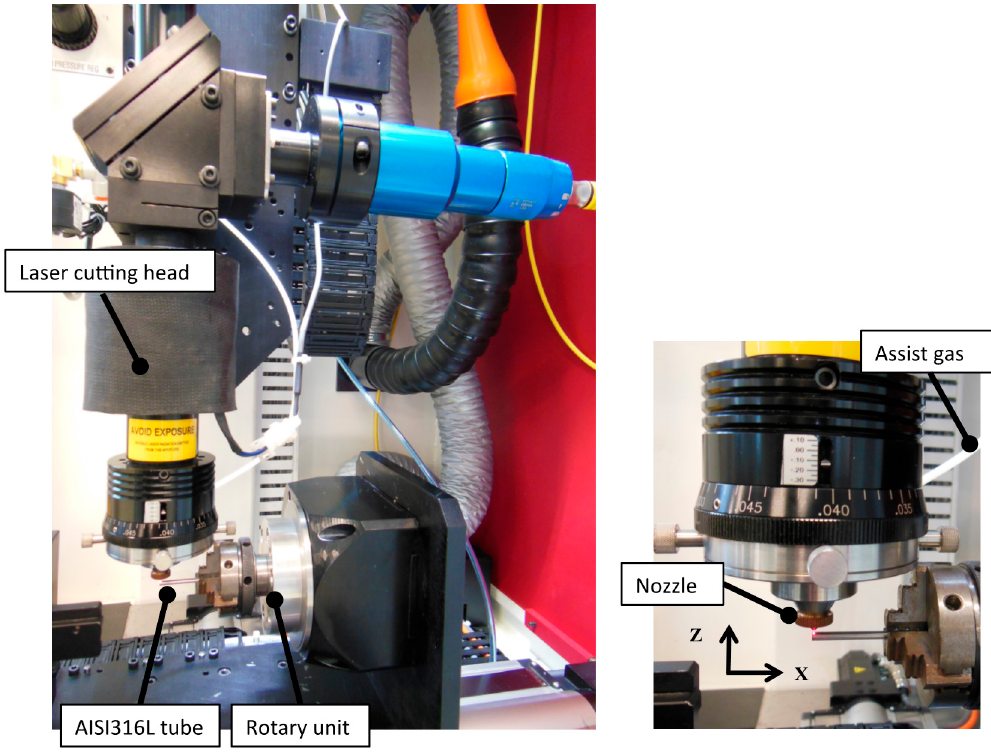
Figure 1. Experimental setup.